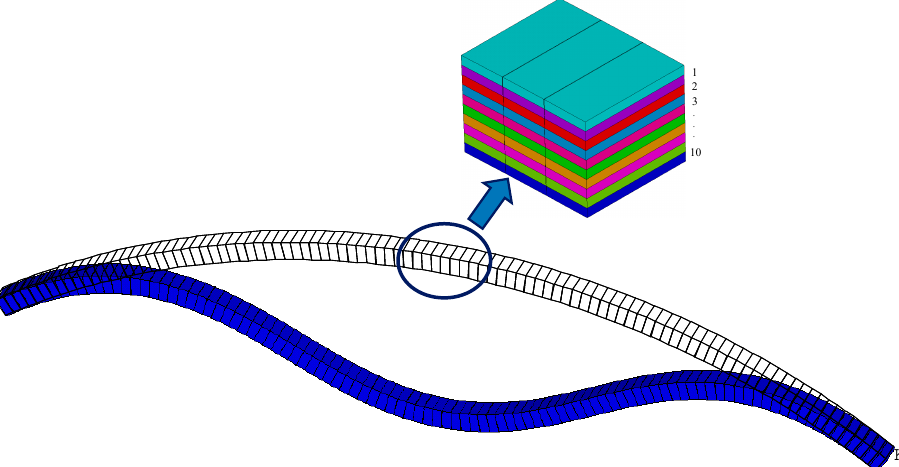
Figure 3. Mesh and deformation of an elastically restrained FG-GPLRC arch.